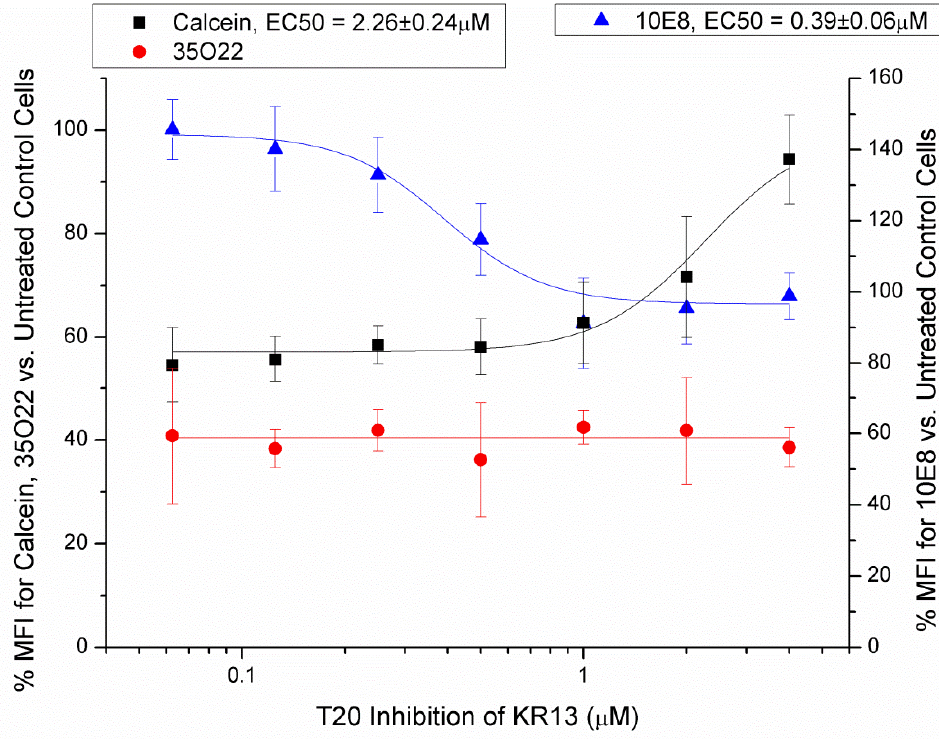
Figure 5. T20 inhibits gp41 and membrane transformations during KR13 treatment of Env-presenting cells. (Left y -axis) Flow cytometry detection of calcein retention (membrane integrity) and 35O22 (gp120 shedding). (Right y -axis) Flow cytometry detection of 10E8 (MPER). Data shown are the average of three independent experiments, and error bars represent the standard deviation of the mean. EC 50 values are presented as x 0 ± the standard error of x 0 .